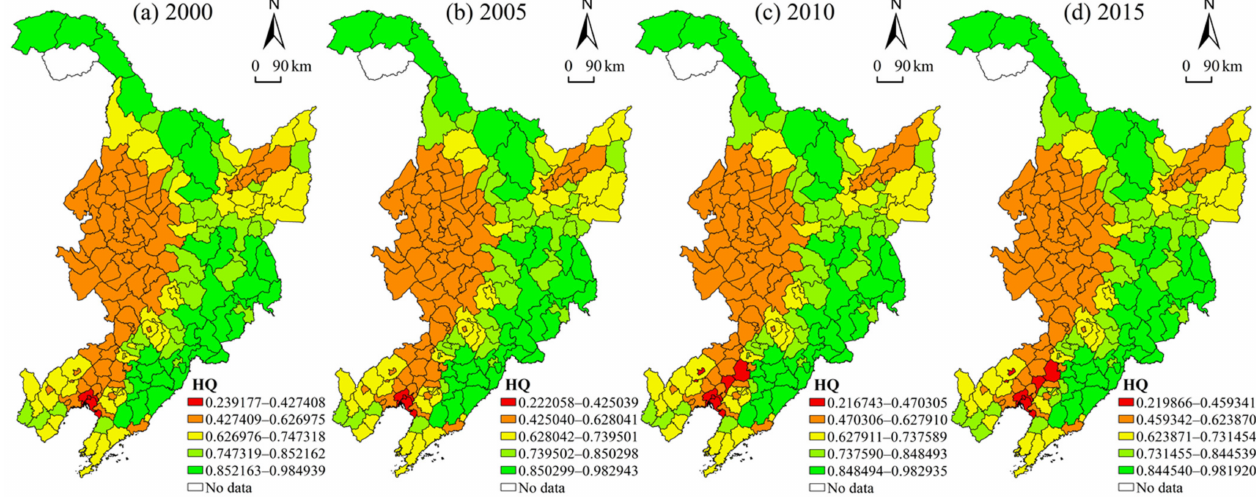
Figure 6. Spatial distribution of HQ in Northeast China for the years ( a ) 2000; ( b ) 2005; ( c ) 2010; ( d )